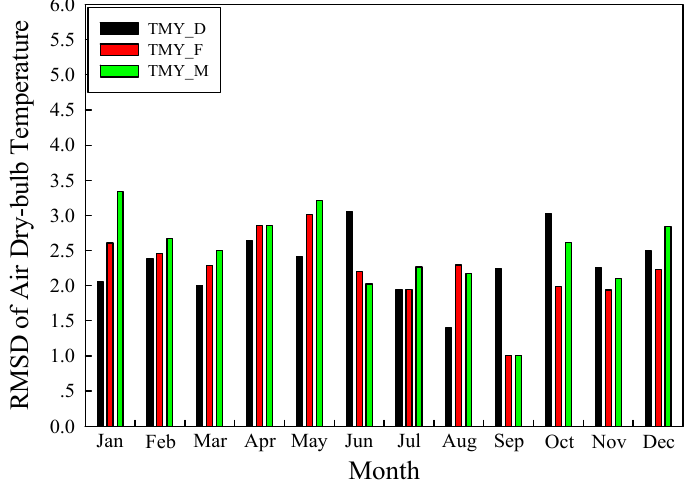
Figure 3. RMSD results of air dry-bulb temperature by the three methods in Lhasa.